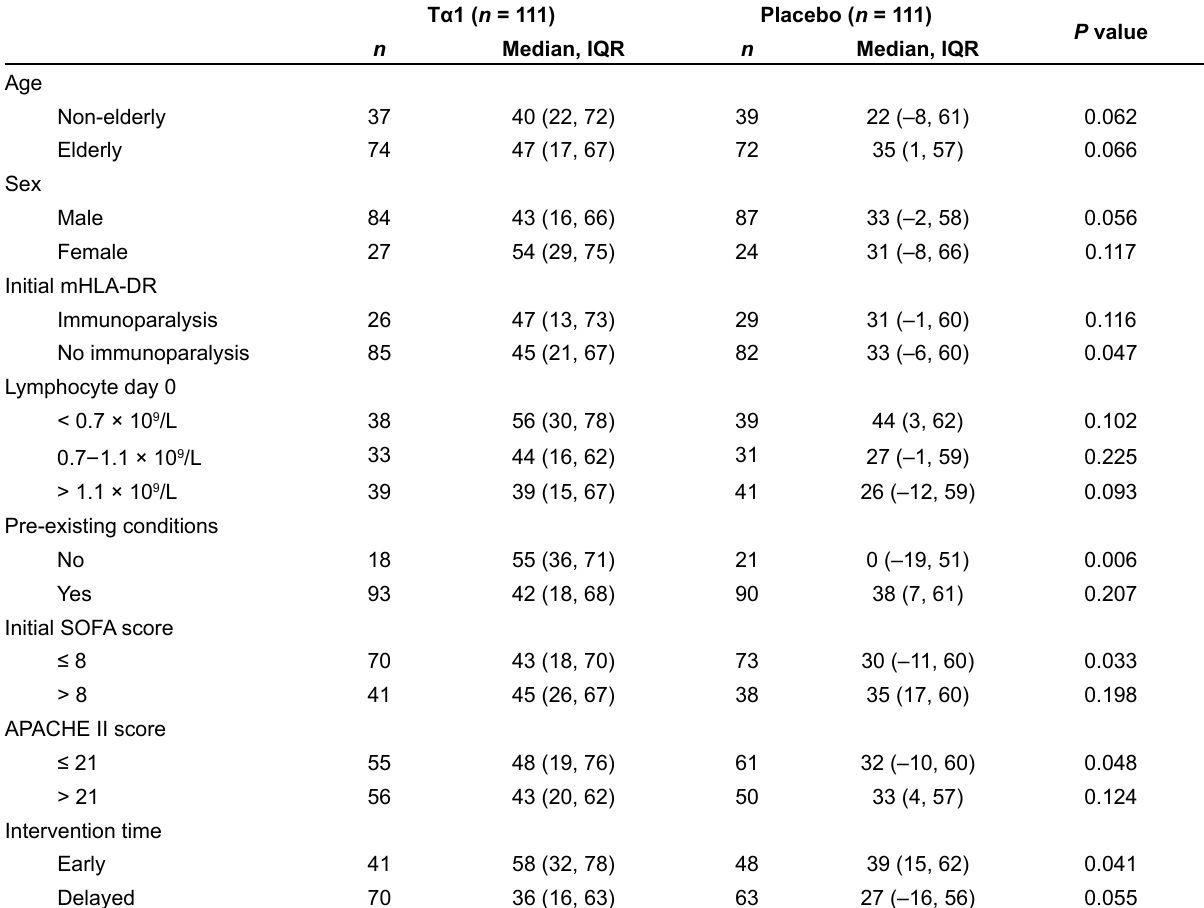
Table 4. Subgroup analysis of ΔSOFAday07 after PSM